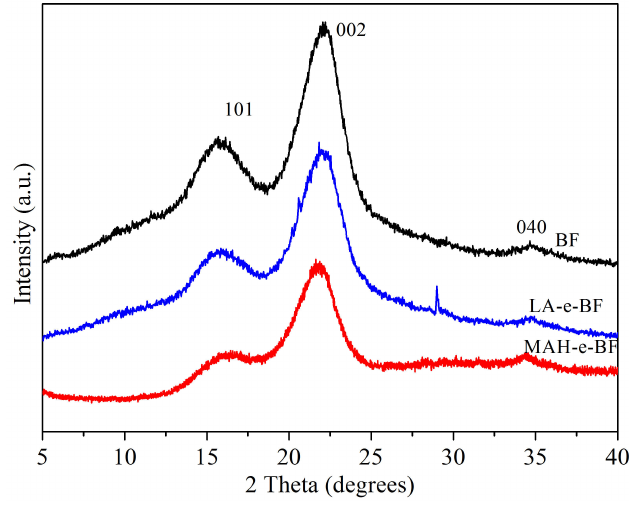
Figure 7. X-ray diffraction pattern of BF, MAH-e-BF, and